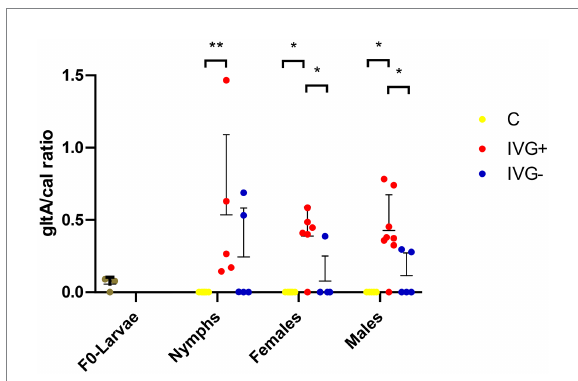
FIGURE 6 qPCR profiles (relative expression) of Spiroplasma spp. Each dot represents the relative rpoB expression in a single sample. The tick calreticulin gene was used as a housekeeping gene. Bars represent mean with the standard deviation shown in error bars. Statistical analysis by Mann–Whitney test performed in Graphpad. IVG + , in vitro feeding with gentamicin; IVG − , in vitro feeding without gentamicin; C, control feeding in vivo on calves. ** p <